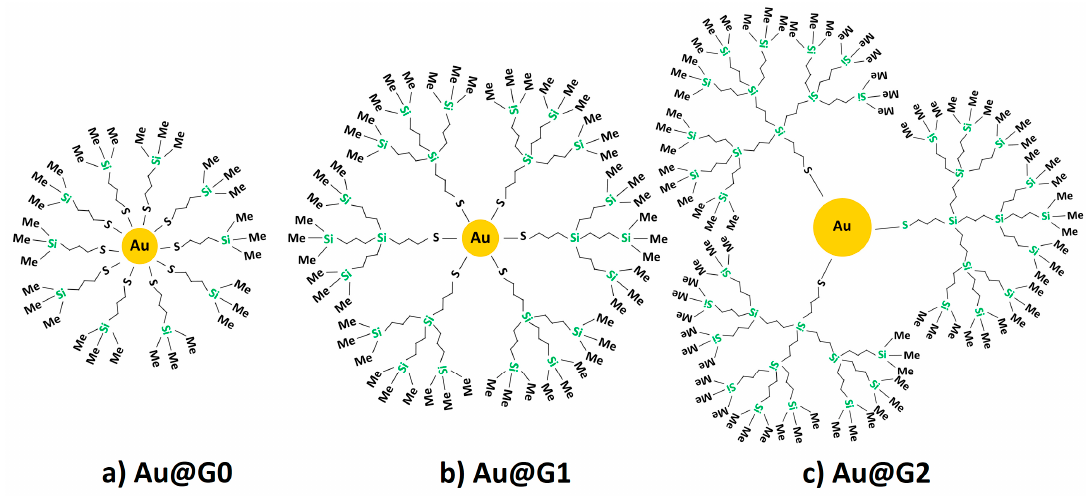
Figure 10. Scheme of the preformed Au NPs, consisting of a gold core encapsulated with ( a ) G0, ( b ) G1 and ( c ) G2 generation of trimethylsilane (TMS) dendrons.